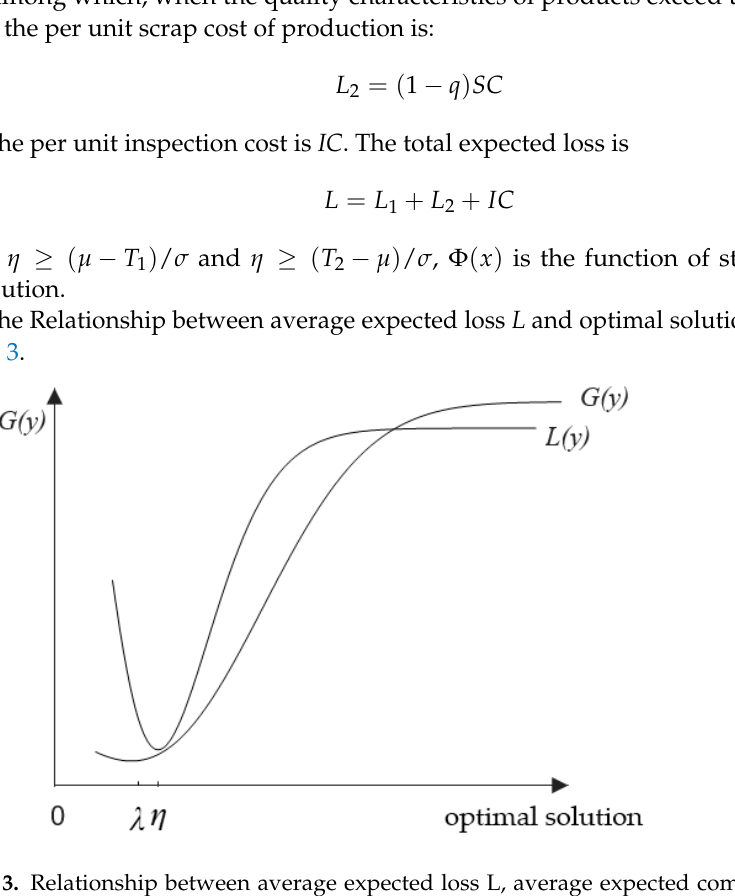
Figure 3. Relationship between average expected loss L, average expected compensation G and optimal solution η , λ .